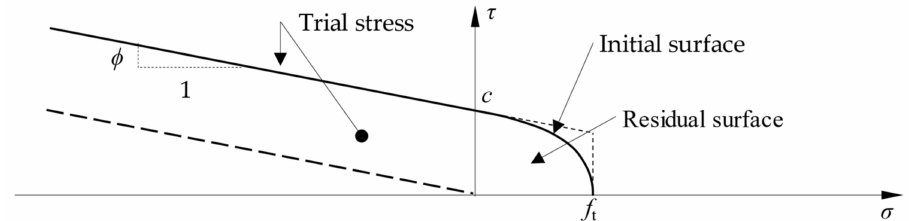
Figure 12. Failure surface for interface